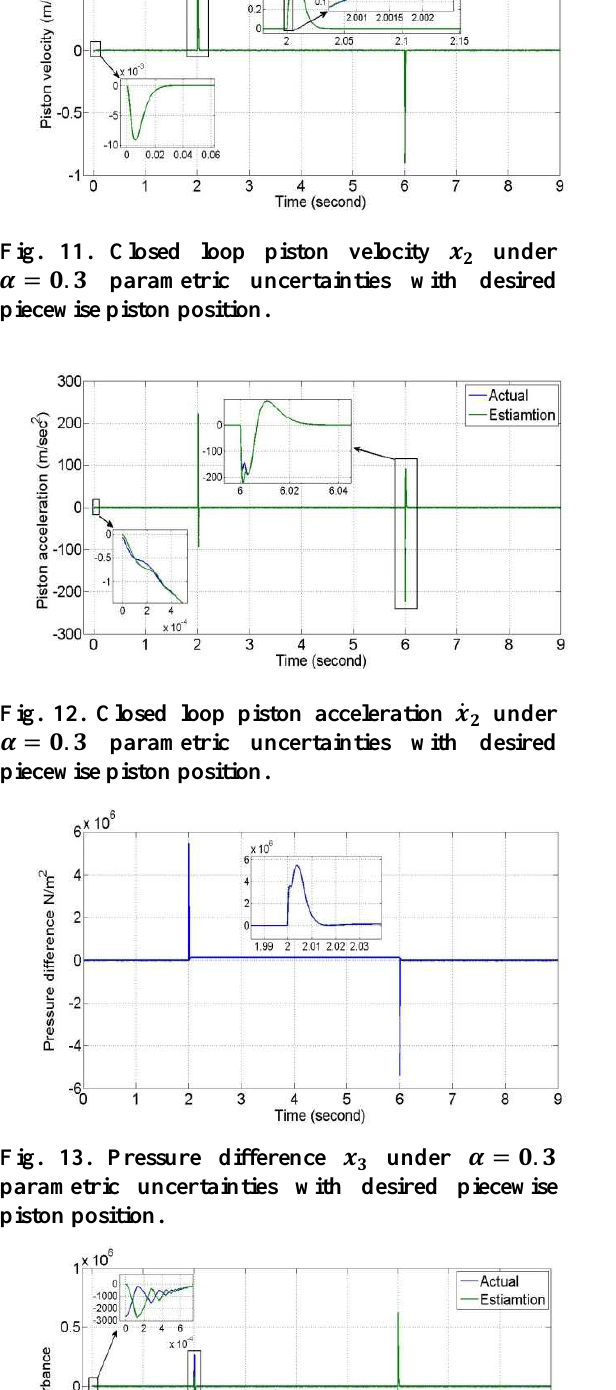
estimation under ¢